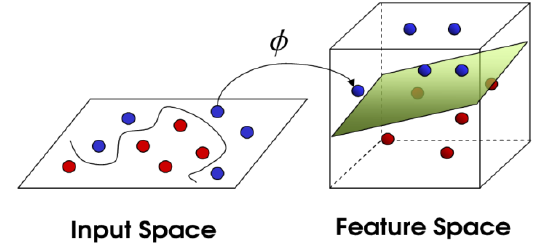
Figure 4. Concept of non-linear kernel